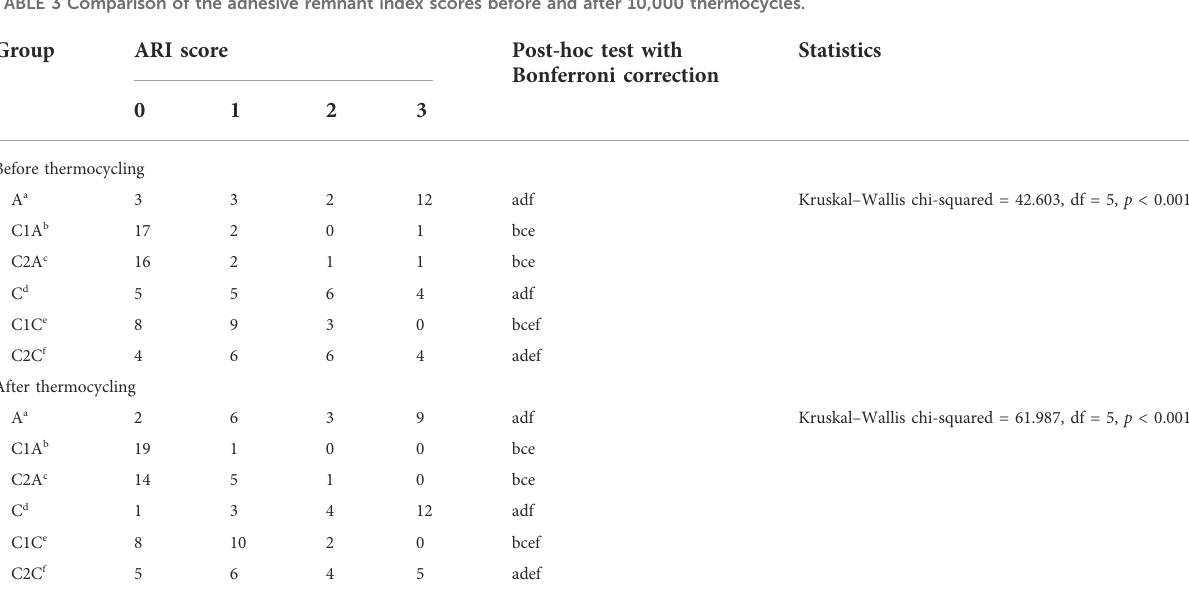
Differentlettersamongthegroups,bothbeforeandafterthermocycling,indicateastatisticallysigni fi cantdifferencewithanadjusted p -value < 0.05,accordingto posthoc comparisonswith Bonferroni correction. A, 35% H 3 PO 4 + conventional orthodontic resin; C, 35% H 3 PO 4 + SAR; C1A, CPICs + H 3 PO 4 -I + conventional orthodontic resin; C2A, CPICs + H 3 PO 4 -II + conventional orthodontic